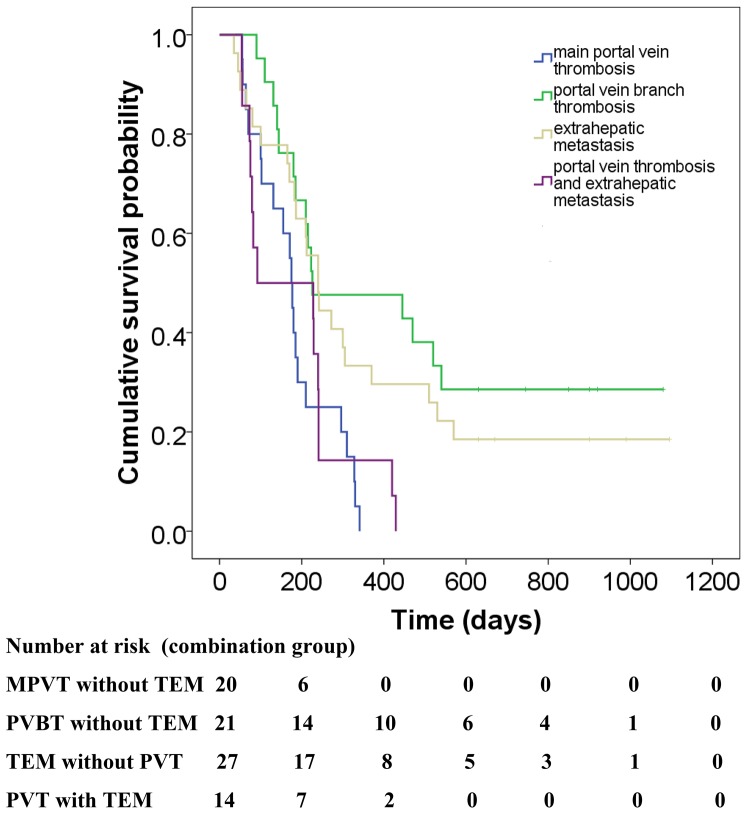
Kaplan–Meier analysis of overall survival of subgroups of the combined group.As shown in Figure 3, two subgroups showed significantly improved OS (the group of patients with portal vein branch thrombosis without tumor extrahepatic metastasis) compared with patients with portal vein thrombosis and tumor extrahepatic metastasisas follows: HR, 0.34; 95%CI, 0.16–0.73; P  = 0.005; Statistical data for the group of patients with tumor extrahepatic metastasis without portal vein thrombosis are as follows: HR, 0.46; 95%CI, 0.23–0.91; P  = 0.027). However, combined therapy did not significantly improve OS of the group with main portal vein thrombosis without tumor extrahepatic metastasis (HR, 1.07; 95%CI 0.54–2.13; P  = 0.848).